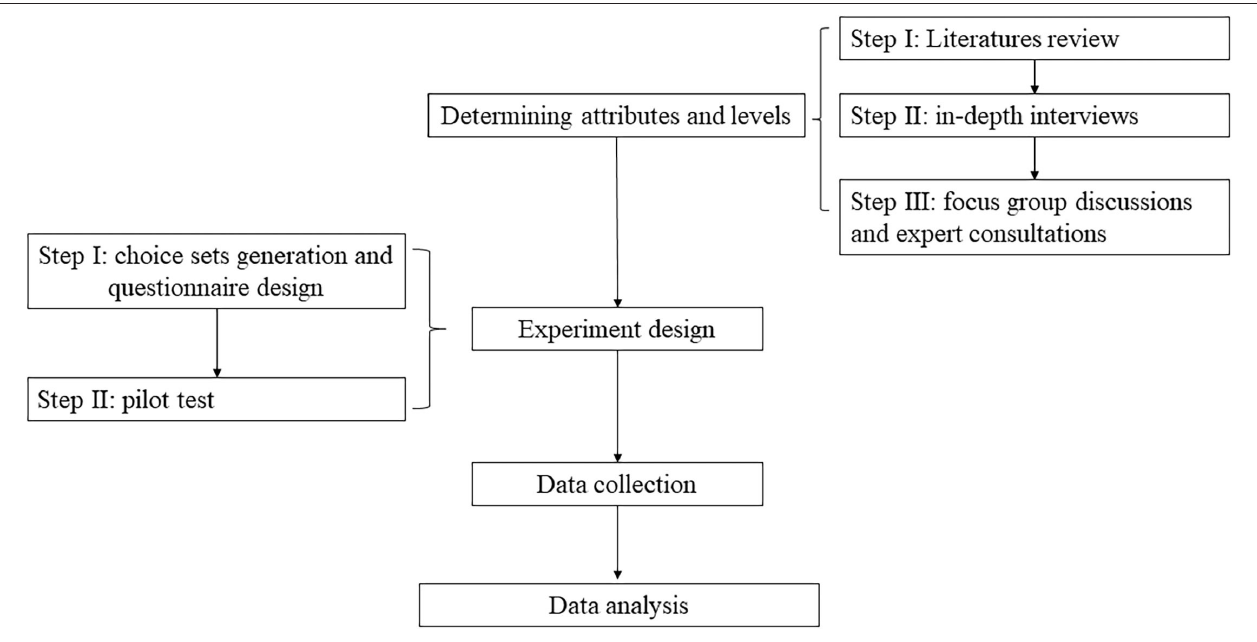
FIGURE 1 | The process of